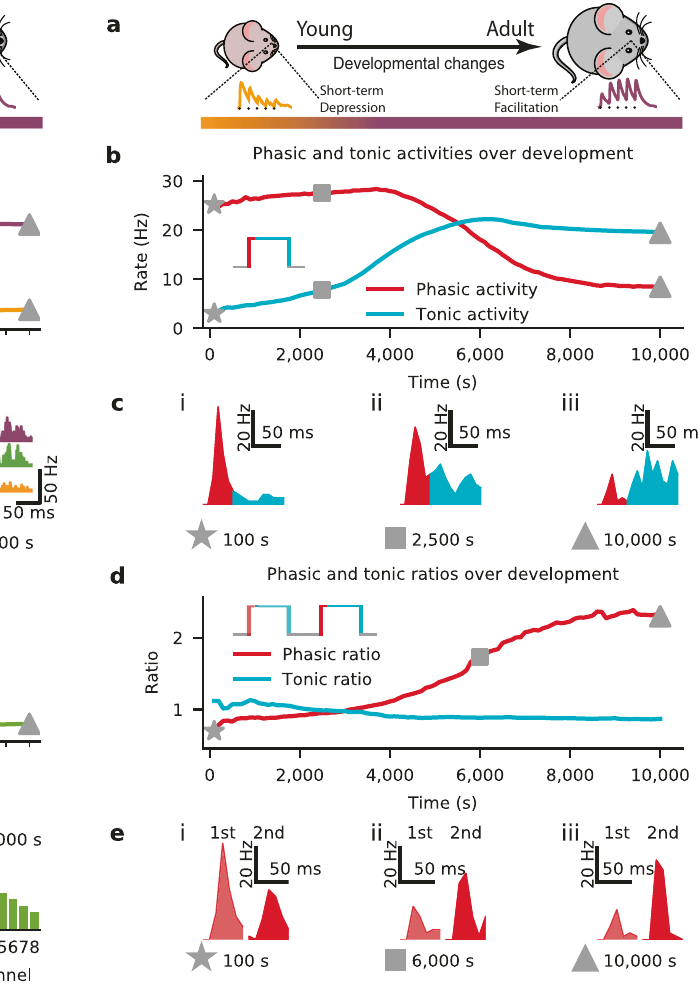
Fig. 5 Developmental STP shaped tonic and phasic input-output transmission. a Schematic of the modeled development from young with depressing synapses (left) to adult facilitating synapses (right), as in previous fi gures. b Average phasic (red) and tonic (blue) postsynaptic fi ring rates for a step-input of 150 Hz (inset; cf. Fig. S6; see Fig. S1 for a comparison between these and other devSTP results). c Example output responses for the phasic (red) and tonic (blue) activities at three points during development. d Ratios of the average phasic (red) and tonic (blue) fi ring rates between two consecutive step stimuli (inset; see Fig. S1 for a comparison between these and other devSTP results). e Examples of responses to the fi rst (light red) and second (dark red) phasic activities in response to the double step-input stimulus at speci fi c points during development. Results shown here were averaged over 50